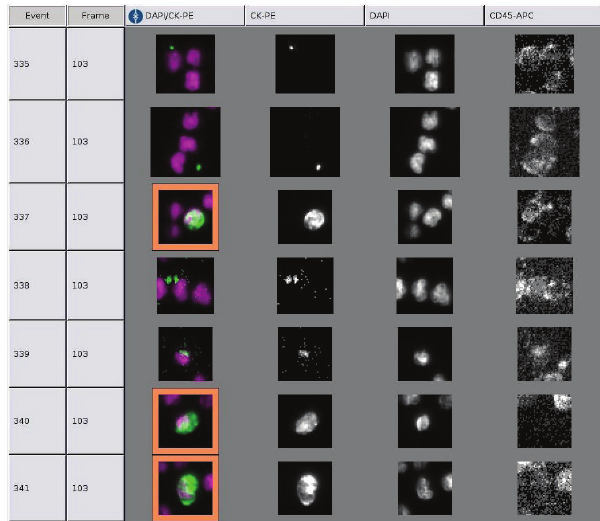
Figure 2: CellSearch thumbnail gallery. The software of the CellSearch CellTracks displays thumbnails of all objects that are positive for both DAPI and CK. Events 337, 340, and 341 show a CTC: positive for DAPI and PE and negative for CD45. Note the weak CD45-staining of several white blood cells in events 340 and